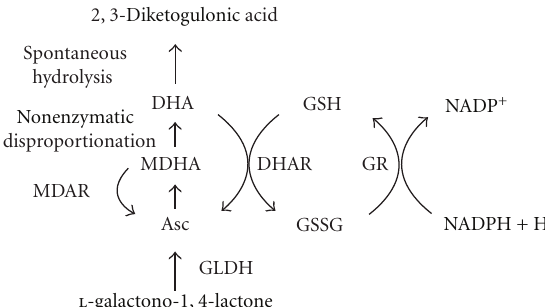
F 2: Role of DHAR and MDAR in -ascorbic acid